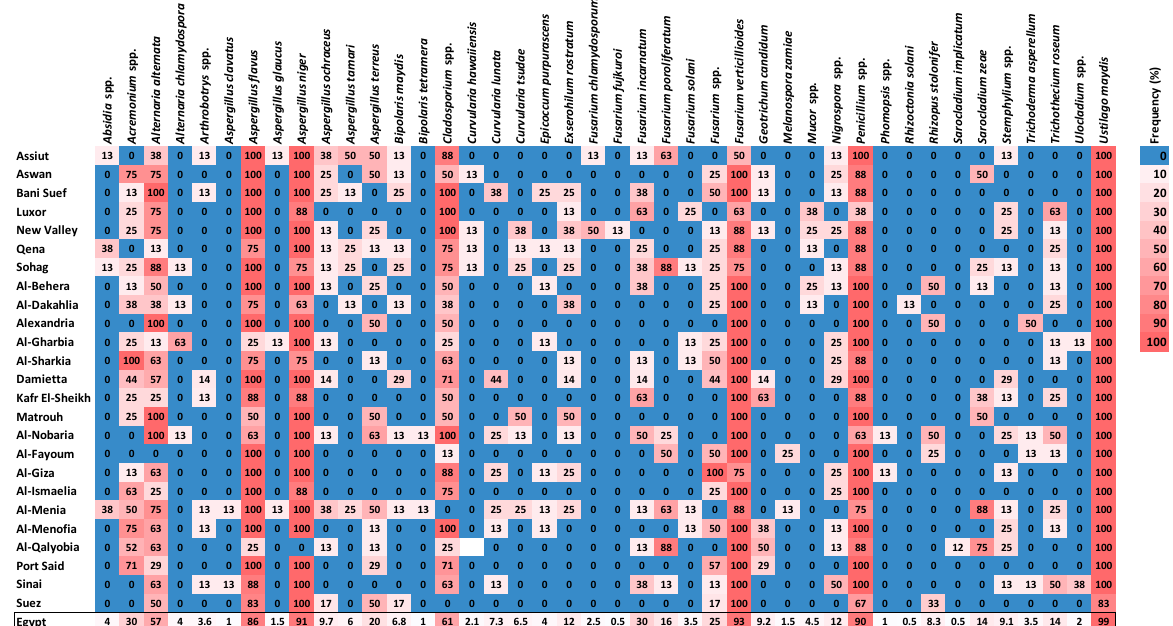
Figure 2. Heatmap showing frequencies of 42 maize seed-borne fungus species in each of the 25 maize-growing governorates of Egypt and for the national average over Egypt. Gradients of frequency key on the right vary from 0 (blue) to 100% (red).